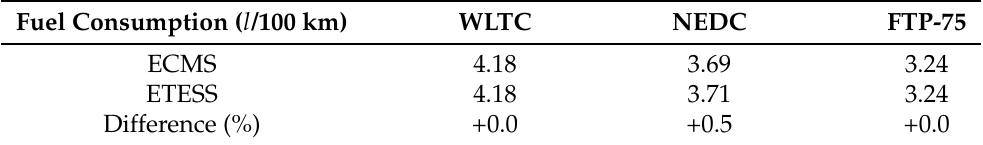
Table 4. Comparison between the fuel consumption by ETESS and ECMS along three type-approval driving cycles.